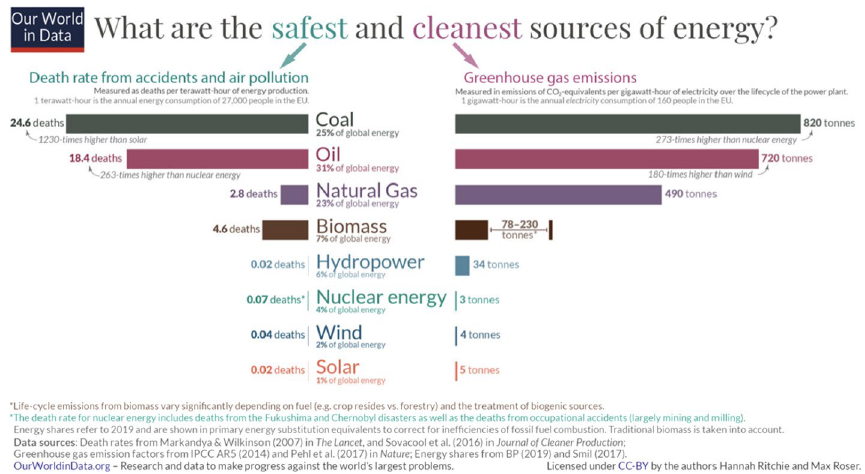
Fig. 5 The safest and cleanest sources of energy (source: Wikimedia Commons, the image is used under a CC BY-SA 4.0